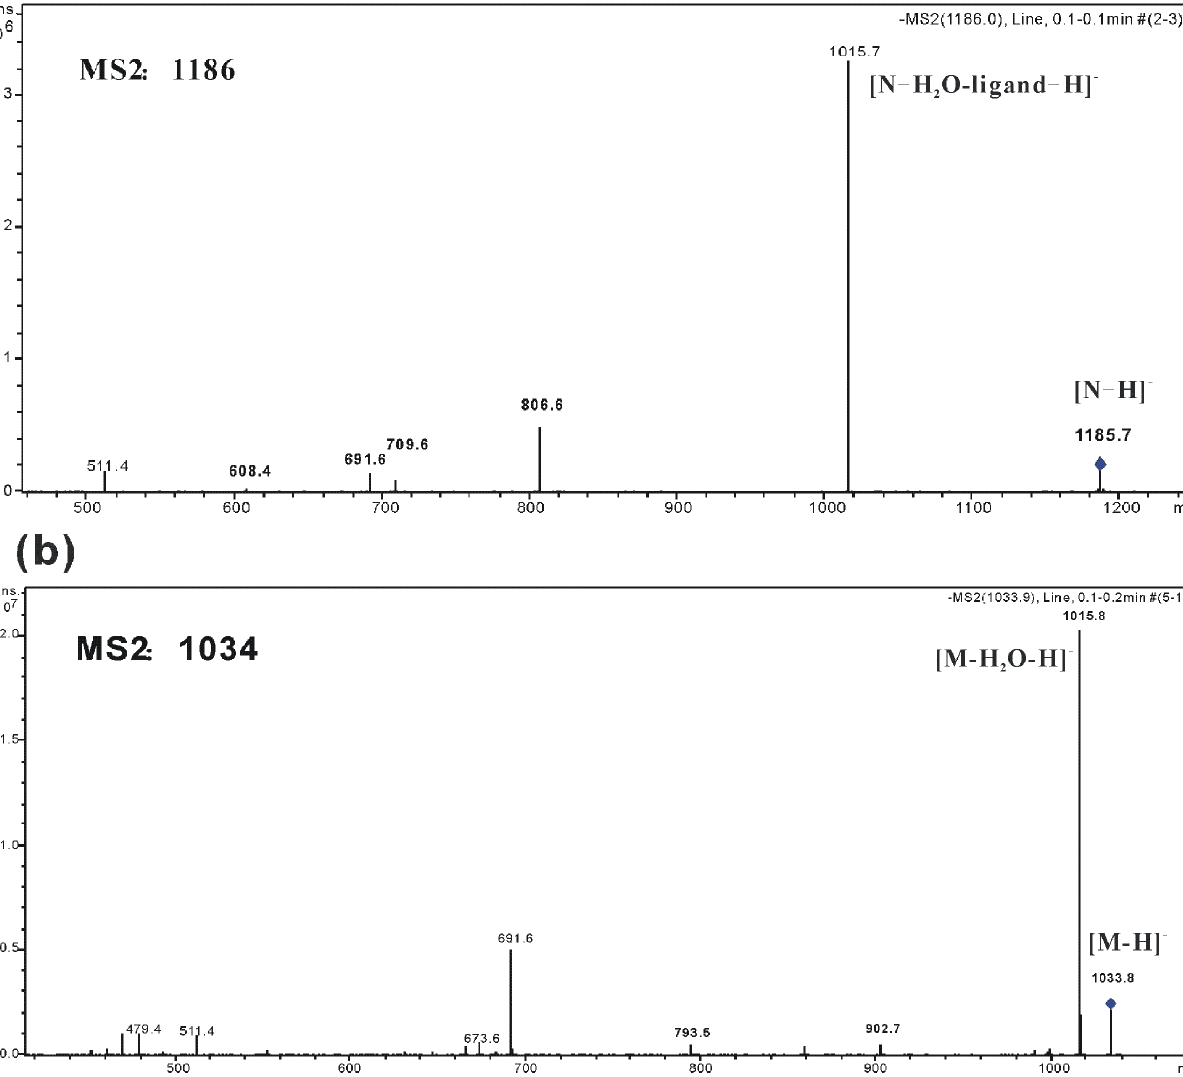
Figure 2. The fragmentation of non-covalent complex (a) and lichenysins G (b). doi:10.1371/journal.pone.0104835.g002 Table 1. Main ions of every fragmentation of Cyclic Lipopetide and Non-covalent complex.